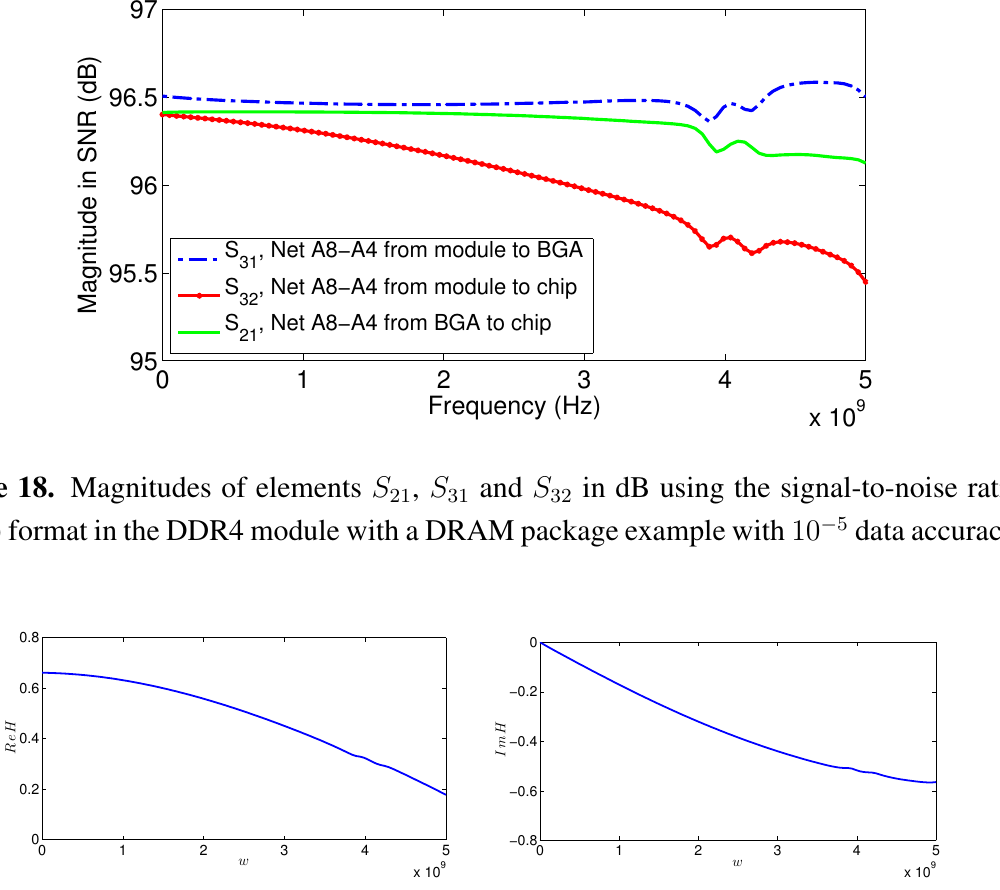
Figure 19. Re H and Im H of the element H ( w ) = S DRAM package